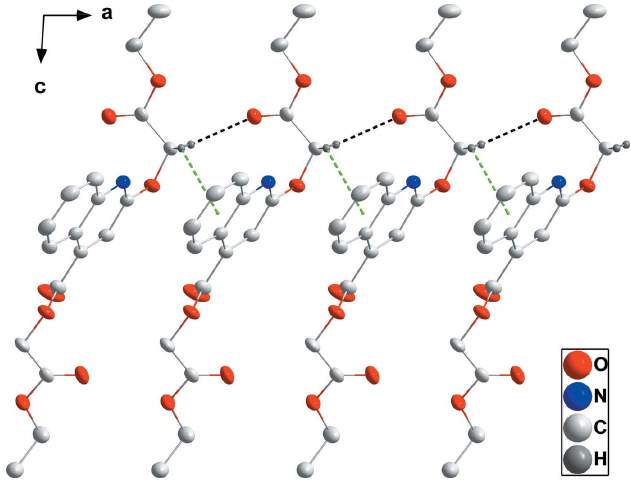
Figure 3 Packing viewed along the b -axis direction with intermolecular inter- actions depicted as in Fig. 2.